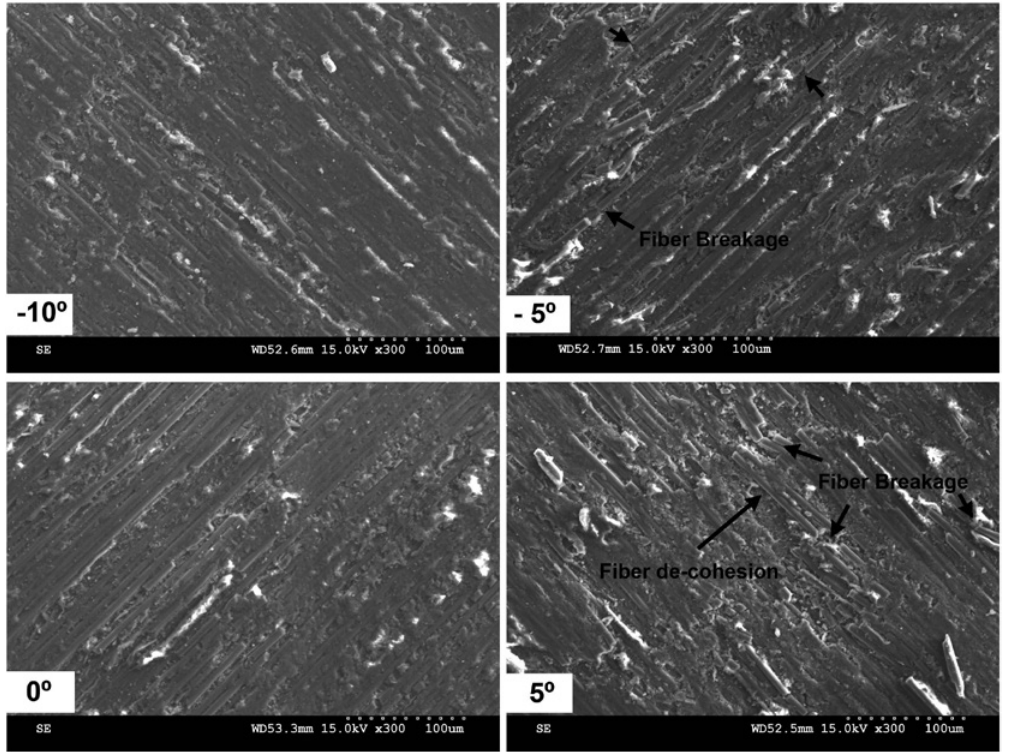
Figure 11: SEM images of machined surface with different lead angles (cutting speed 250 m/min and feed rate 0.063